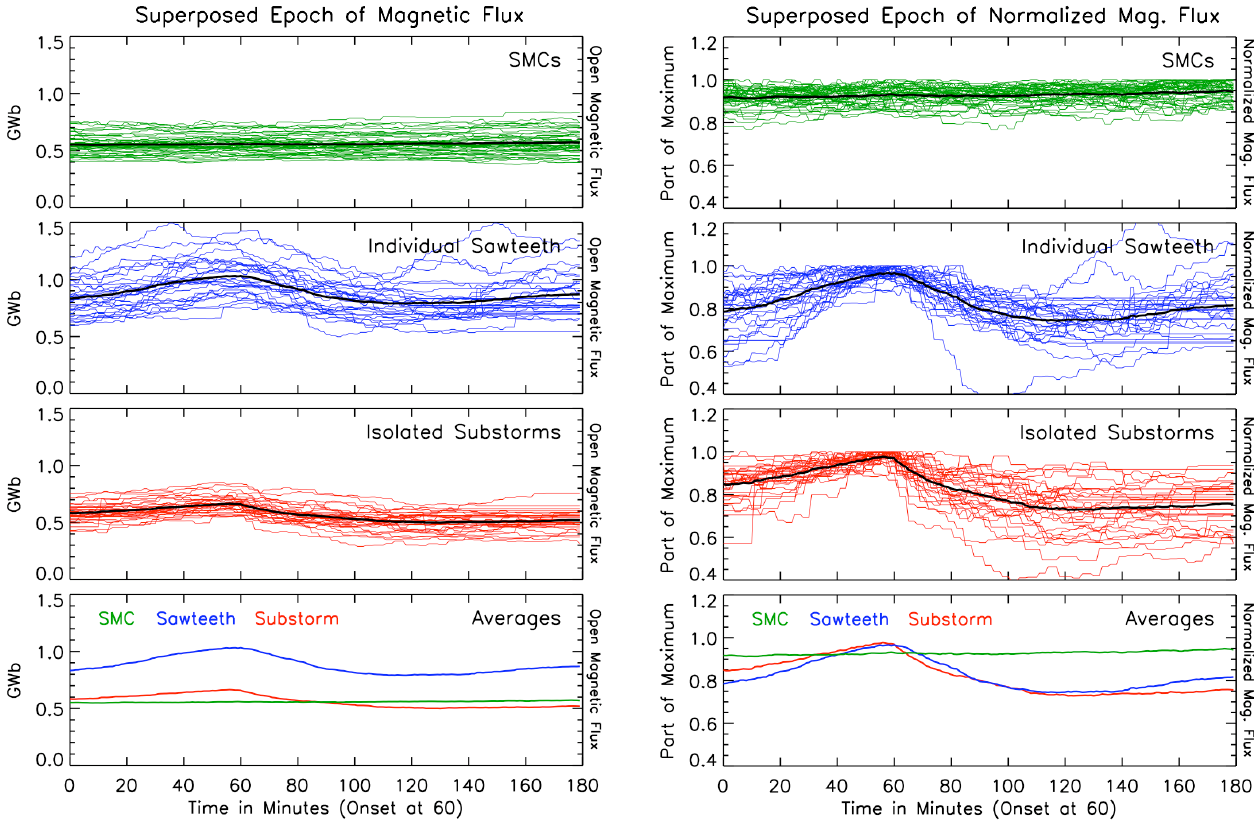
Fig. 10. Superposed epochs of the polar cap open flux for SMCs, isolated substorms and individual sawteeth. The average of are replotted on the bottom. Left is the actual F pc in gigawebers and right is the F pc normalized by the maximum area for the time